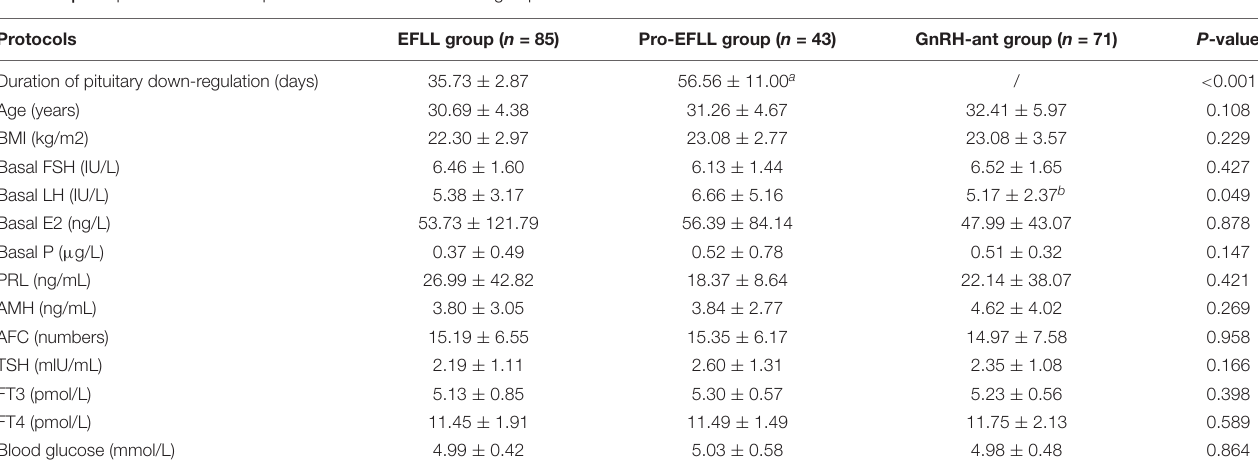
Data are shown as means ± standard deviation. BMI, body mass index; FSH, follicular-stimulating hormone; LH, luteinizing hormone; E2, estradiol; P, progesterone; AMH, anti-Müllerian hormone; AFC, Antral Follicle Countin; TSH, thyroid stimulating hormone. a P < 0.05, vs. early follicular phase long-acting GnRH agonist long protocol (Group A). b P < 0.05, vs. prolonged GnRH-a down-regulation in fertility patients during the COVID-19 pandemic (Group